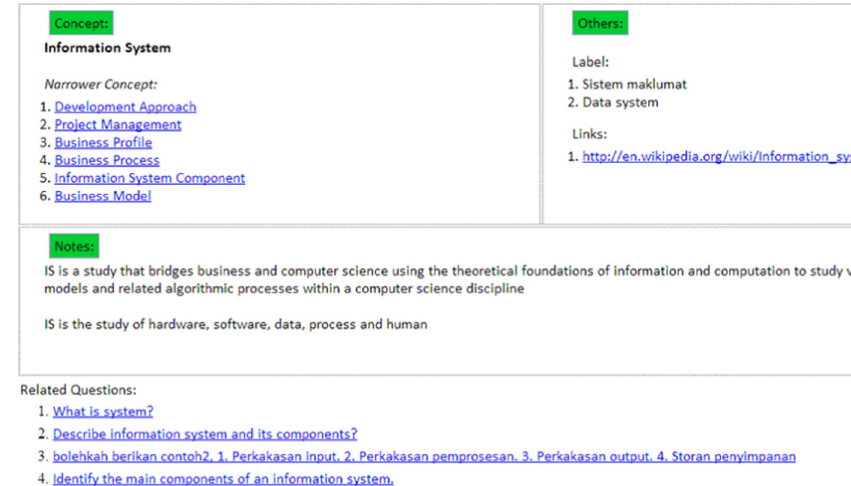
Figure 7. Example of concept details